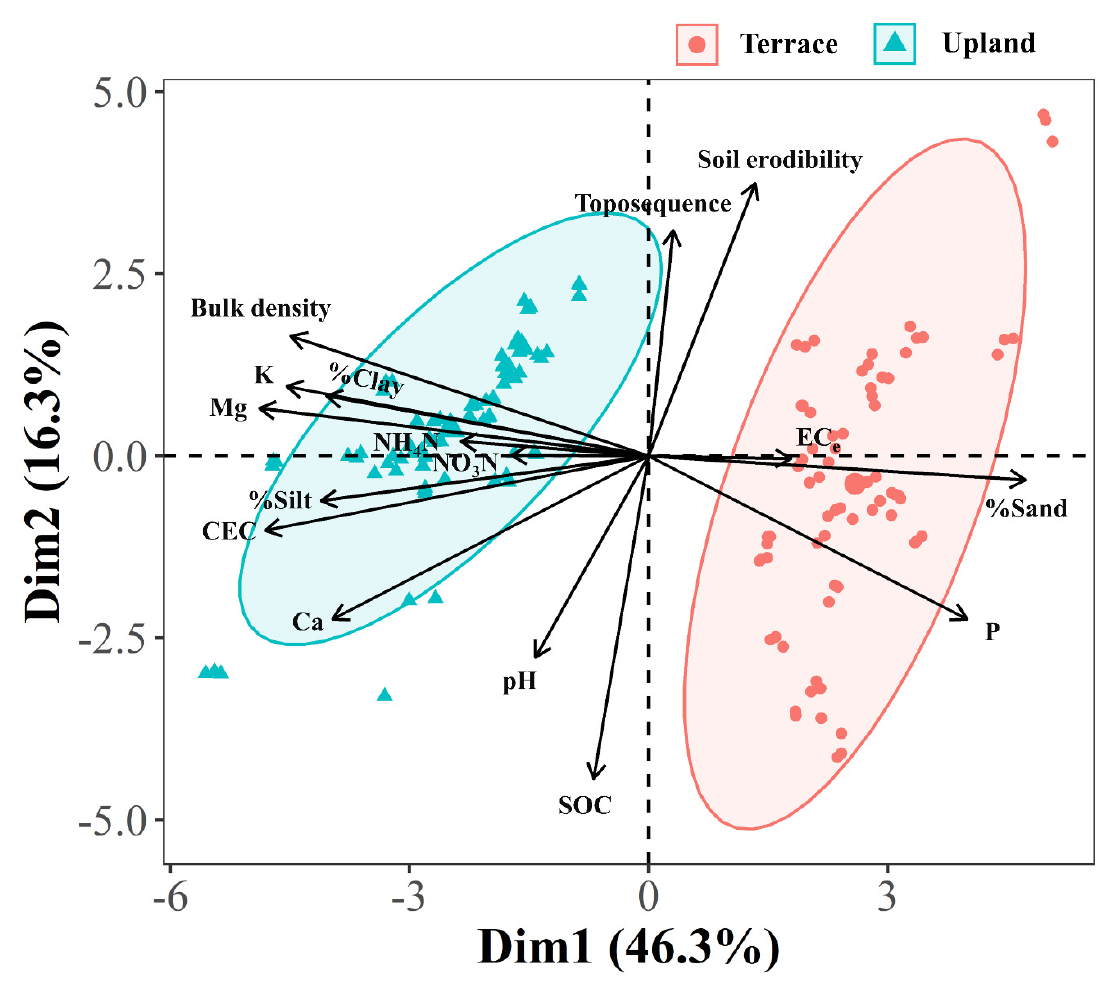
Figure 6. Principal component analysis (PCA) and the loading values of soil properties and toposequences for terraced paddy field samples (red area) and upland rice samples (blue area). Table 3. Principal components (PCs), eigenvalues, percentage of variance explained by the PCs (% Var.) and cumulative percentage of variance explained by PCs of soil properties and toposequences for terraced paddy field and upland rice samples.